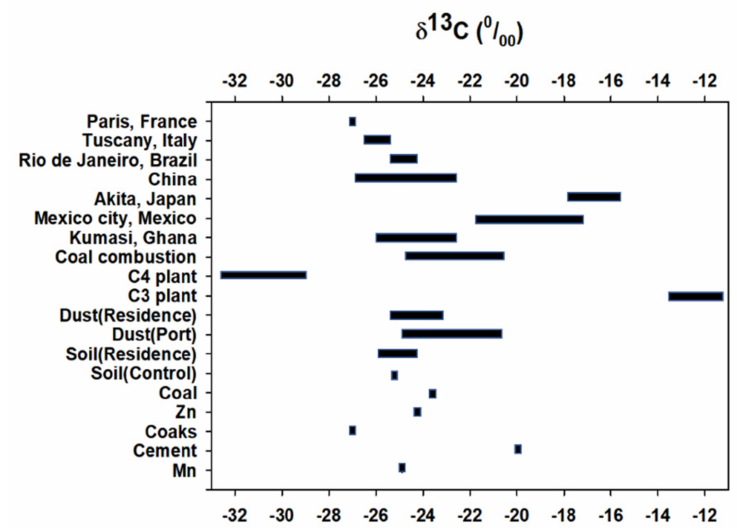
Figure 3. Comparison of δ 13 C values between this study and literature reports, including coal- combustion [106], biomass burning from C 3 and C 4 plants [107,108] and various urban region: Kumasi, Ghana [46]; Mexico city, Mexico [104]; Akita, Japan [105]; several major cities in China [109]; Rio de Janeiro, Brazil [110]; Tuscany, Italy [111]; and Paris, France